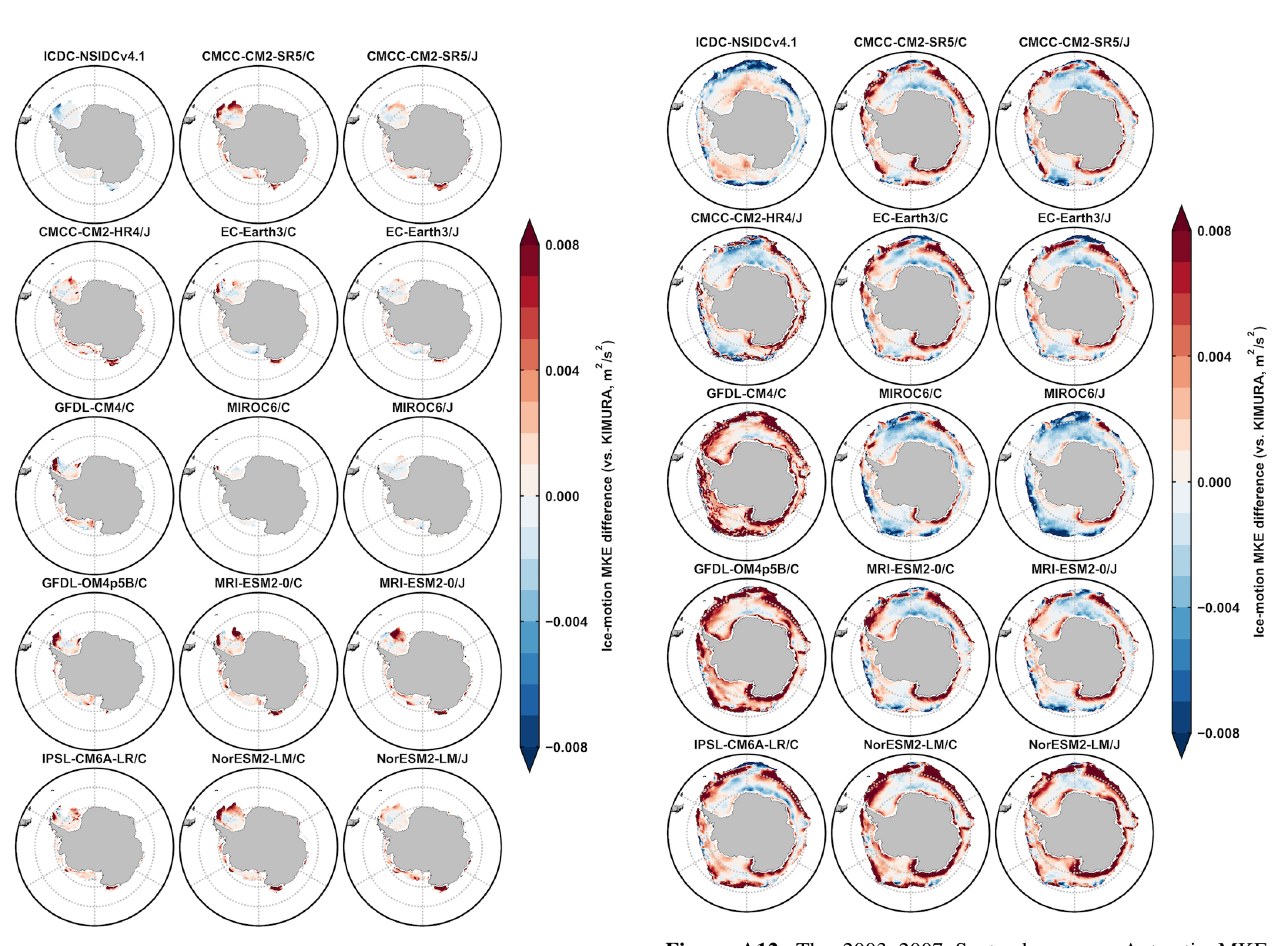
Figure A11. The 2003–2007 February mean Antarctic MKE differ- ences between ICDC-NSIDCv4.1/model outputs and the KIMURA data (m 2 s − 2 ). The second and third columns are from the five OMIP1 and OMIP2 model outputs of CMCC-CM2-SR5, EC- Earth3, MIROC6, MRI-ESM2-0, and NorESM2-LM, respectively.